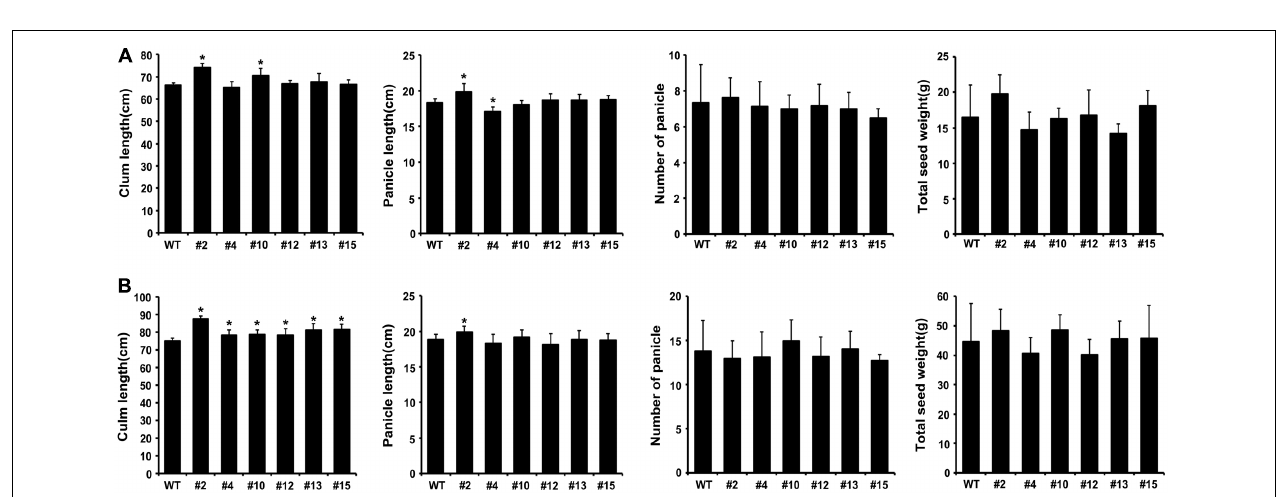
FIGURE 5 | Growth characteristics of transgenic rice plants expressing dominant-negative OsKAT2(T235R) mutant protein. Culm length panicle length, number of panicles and total seed weight of wild-type and T2 (A) , T3 (B ) transgenic rice plants were measured in approximately 16-week-old plants grown in a paddy field under normal conditions. Asterisks indicate a significant difference (one-way ANOVA with Turkey’s test, ∗ p -value < 0.05).